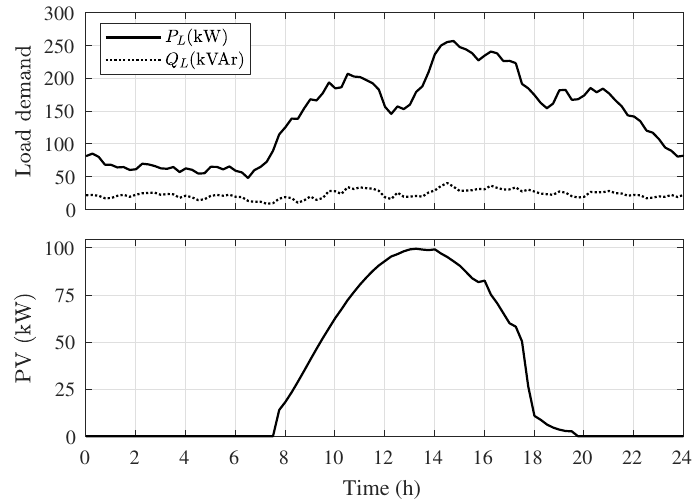
Figure 8. Microgrid profiles of the active and reactive load demand, and the PV generation.